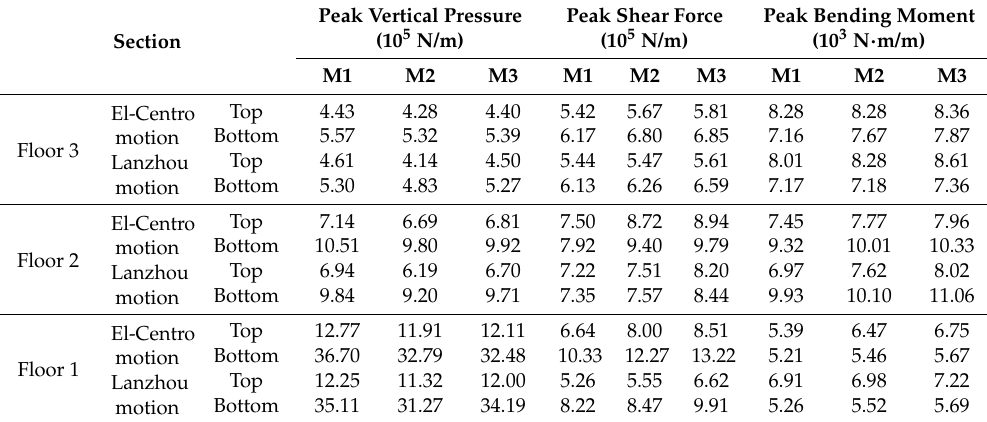
Figure 21. The peak internal force of each section on surface-6 under El-Centro motion. Table 9. The peak internal forces of each section on surface-6 under 0.20 g. Section